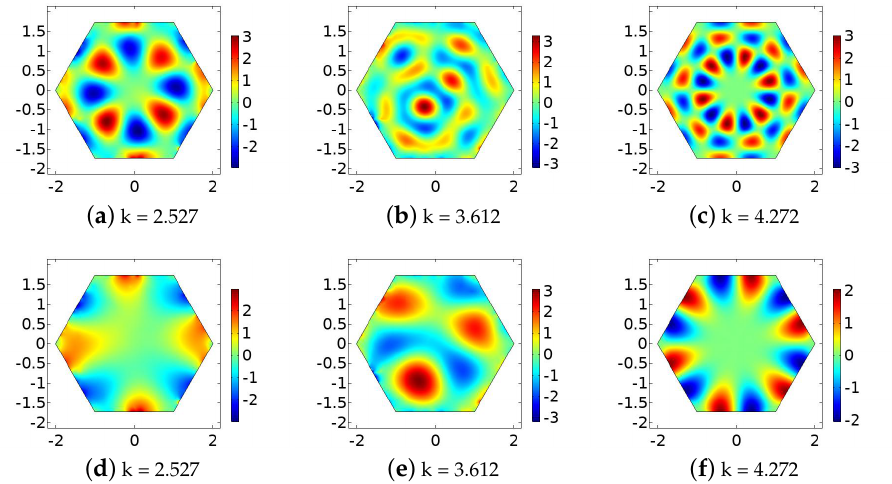
Figure 1. The magnitude of transmission eigenfunctions for a regular hexagon with different eigenvalues. ( a – c ): eigenfunctions w ’s; and ( d – f ): eigenfunctions v